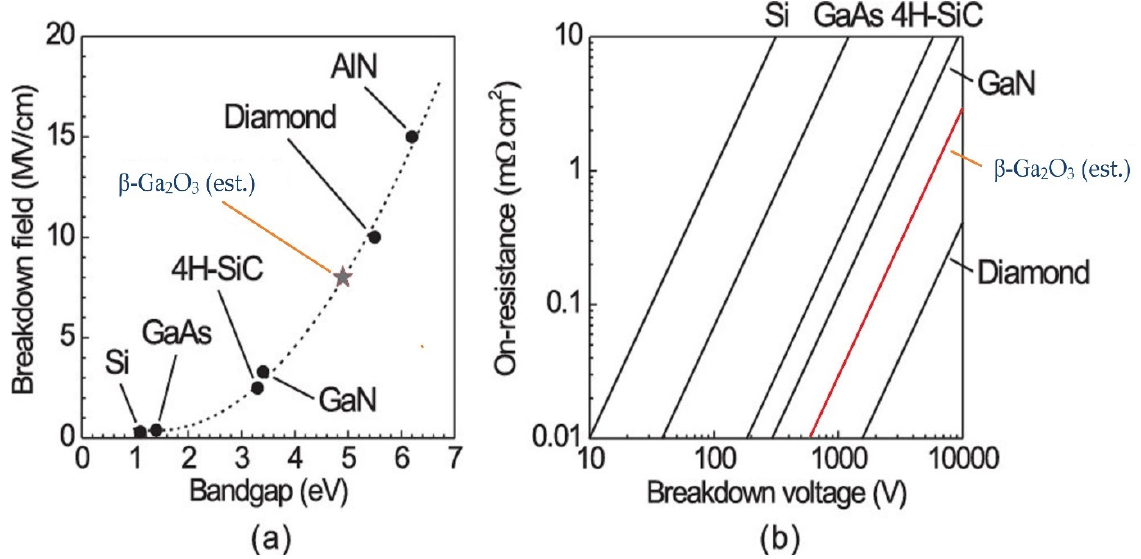
Figure 11. Comparison of breakdown field of various semiconductors ( a , b ) [1]. “Reprinted with permission from Ref. [1]. Copyright (2013), AIP Publishing”. Table 4. Common properties of β -Ga 2 O 3 .